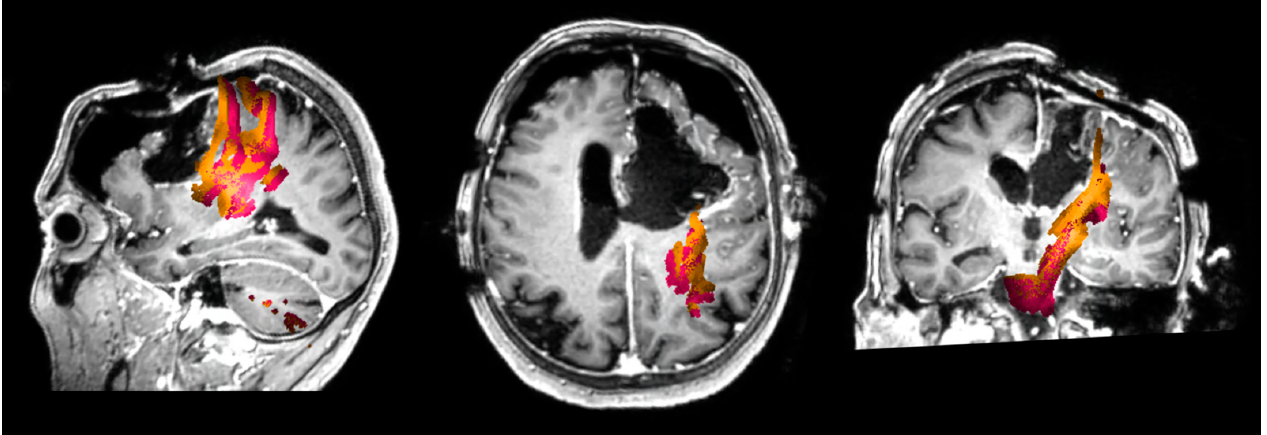
Figure 1. Navigated transcranial magnetic stimulation-based (nTMS) motor tractography corrected by intraoperative magnetic resonance imaging-based elastic fusion (IBEF)in an intraoperative magnetic resonance imaging (ioMRI)scan. This figure shows motor fiber tracts based on navigated transcranial magnetic stimulation (nTMS) in an intraoperative magnetic resonance imaging (ioMRI) scan in an exemplary patient case. The preoperative motor fiber tracts are shown in orange. The fiber tracts corrected by ioMRI-based elastic fusion (IBEF) are shown in pink.